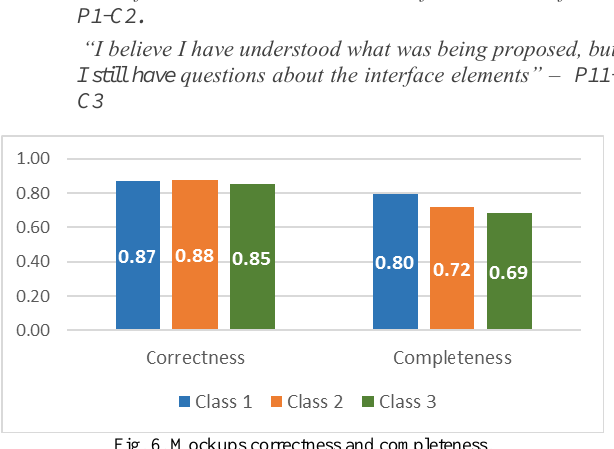
Fig. 6. Mockups correctness and completeness.